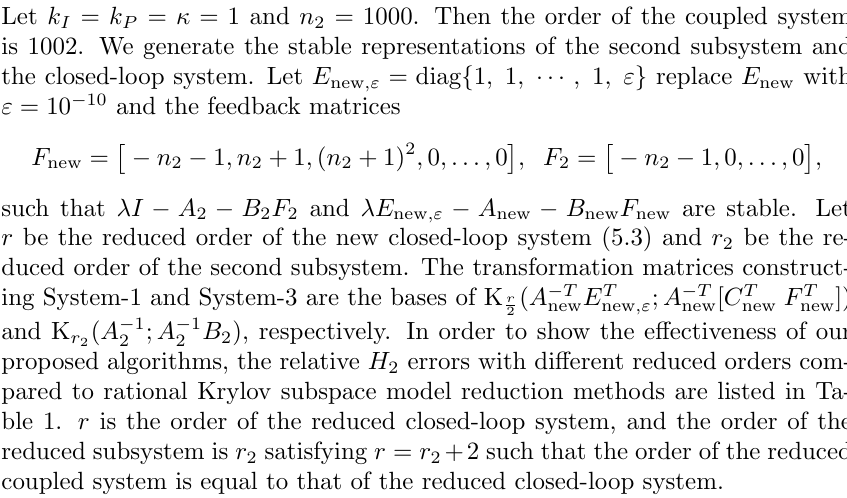
Table 1. Relative H 2 errors in Example 1.